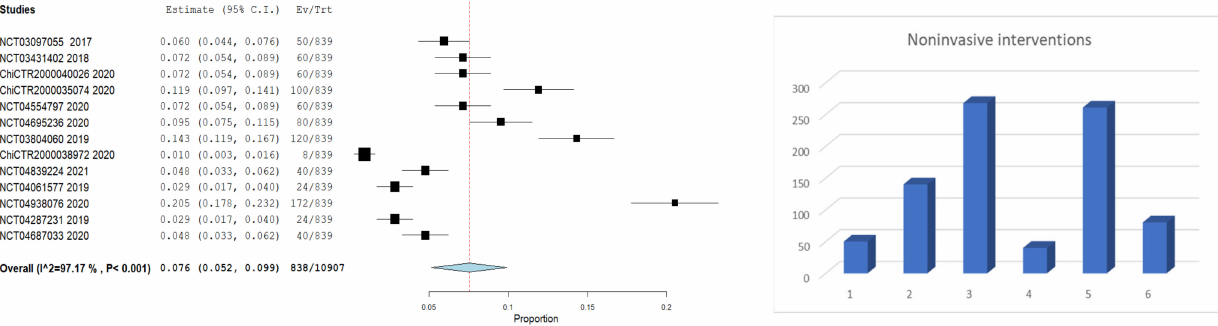
Figure 10. Forest plot—frequency of non-invasive, non-pharmacological